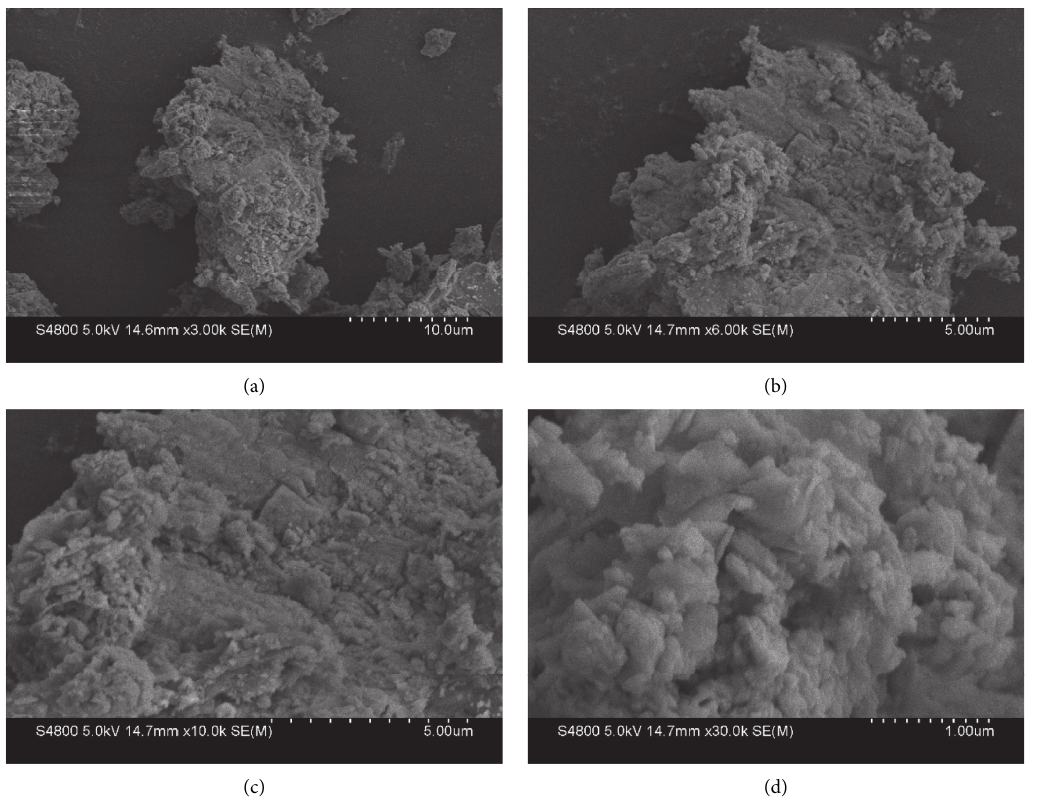
Figure 2: SEM images of studied materials. (a) 3000 times. (b) 6000 times. (c) 10000 times. (d) 30000